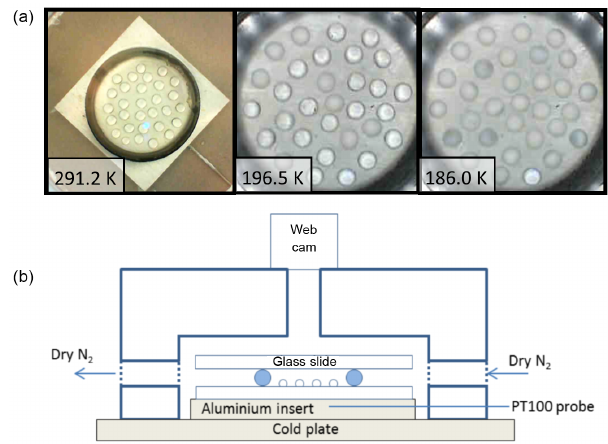
Figure 2. Droplet array on cooling, demonstrating that crystalliza- tion and therefore nucleation temperatures can be distinguished. Panel at room temperature shows the supporting cold plate, alu- minium insert with PT100 temperature probe and slide–spacer– slide cell configuration. Panels below room temperature show nu- cleation events for a 39.98wt% HNO 3 solution with 0.045wt% of ground Chergach meteorite particles in suspension (in one droplet shown in the lower right, no nucleation was observed even at 186K). A side-on schematic diagram of the apparatus is also shown (see Sect.